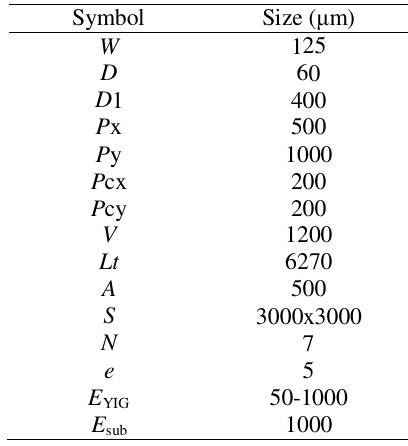
Table 1. Values of the geometrical parameters of the spiral inductor